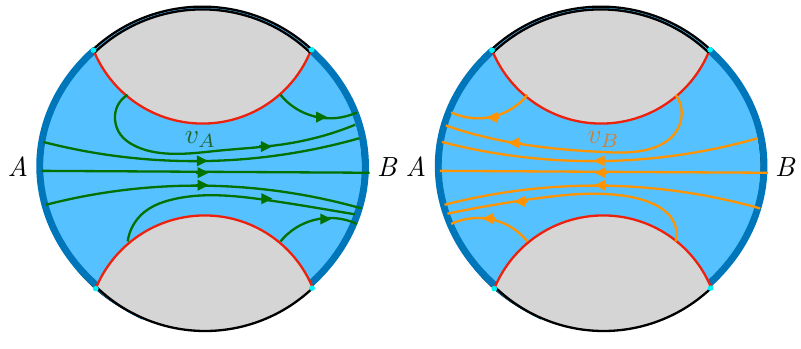
Figure 19 . An example of a general (cid:13)ows v